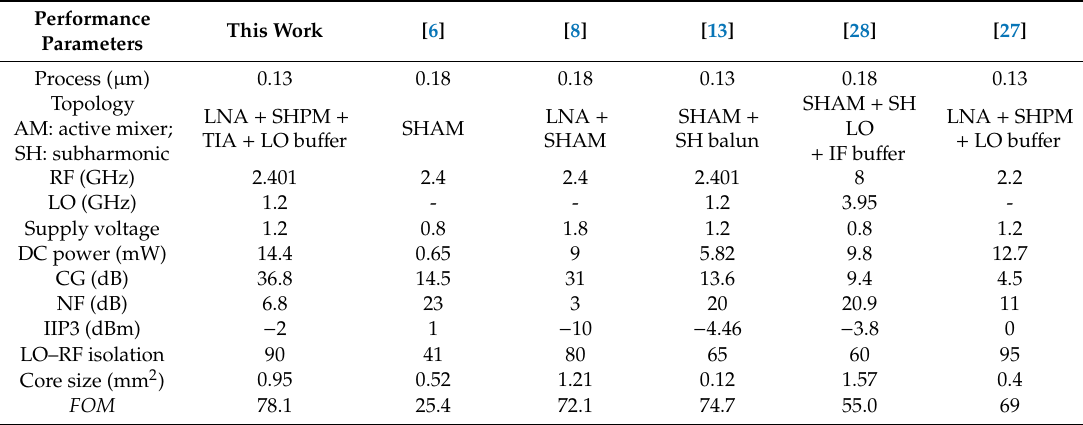
Table 1. Performance comparison with published front